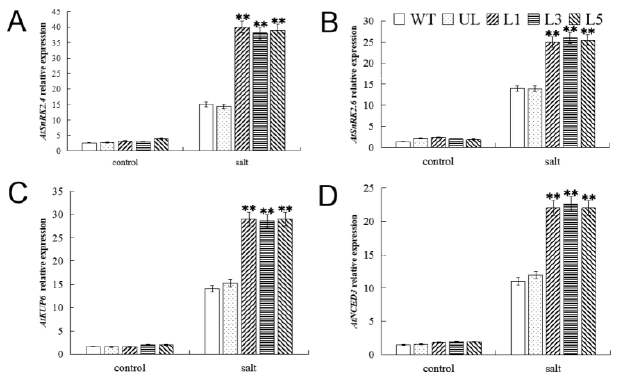
Figure 7. Expression levels of salt-related genes in WT, UL, and transformed A. thaliana. overex- pressing FvMYB82 under salt stress. Relative expression levels of ( A ) AtSnRK2.4 , ( B ) AtSnRK2.6 , ( C ) AtKUP6 , and ( D ) AtNCED3 in the WT, UL, and FvMYB82 -OE lines (L1, L3, and L5). Data are the average of three replicates. Significant differences are marked with an asterisk above the error bar (** p ≤